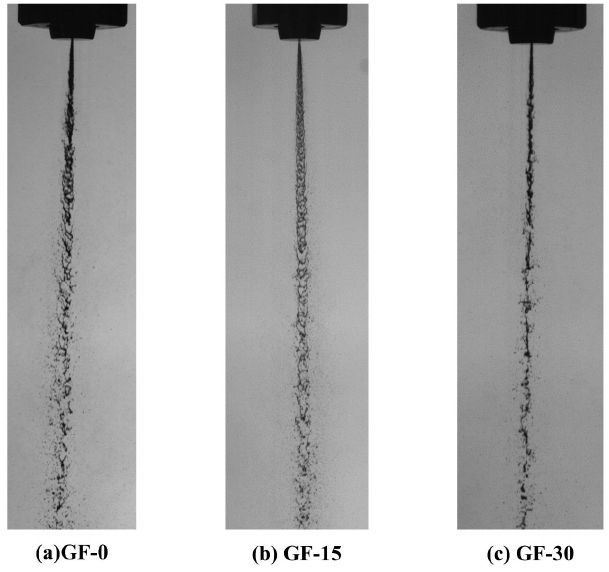
Figure 5. Spray images of different gelled fuels using DC nozzles. Table 2. The injection pressure and the mean droplet diameters of the DC nozzle for different gelled fuels.